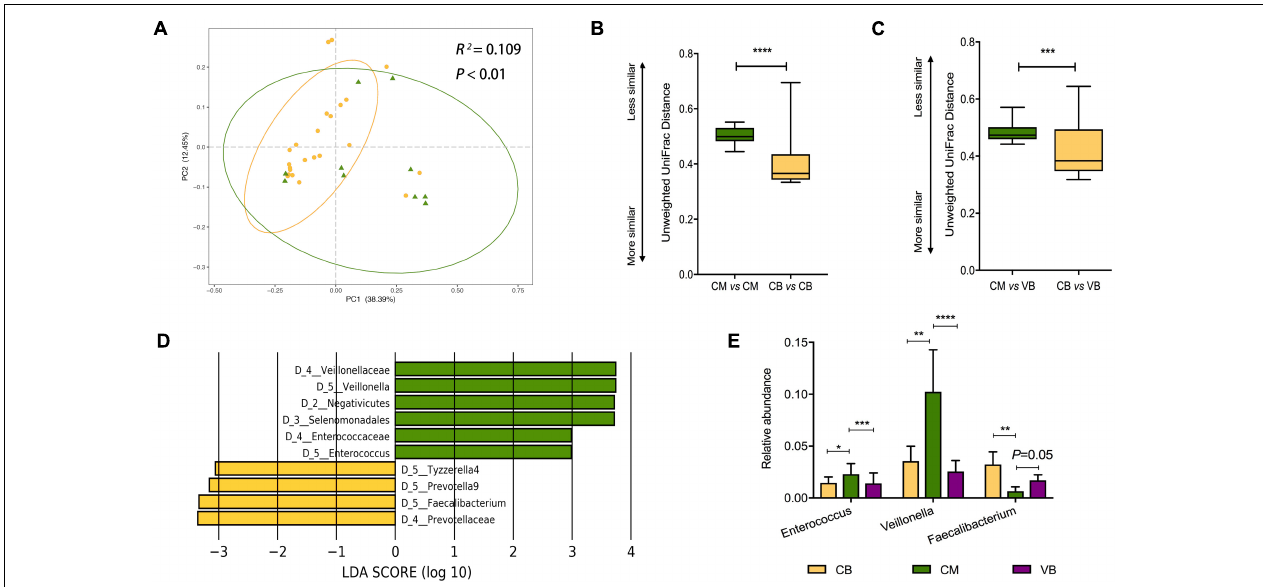
FIGURE 3 | Exclusive breastfeeding significantly restores the gut microbiota of cesarean delivered infants. (A) Principal coordinates analysis (PCoA) based on unweighted UniFrac distances is shown along the first two principal coordinate (PC) axes with Adonis p -value. Percentages are the percent variation explained by each PC axis. Individual samples are represented by yellow points (CB) and green triangles (CM). Comparison of the within-groups (B) and between-groups (C) unweighted UniFrac distances of CB and CM infants. Shorter distance indicated greater similarity between microbial community composition. Significant difference was determined by Mann-Whitney U -test ( ∗ p < 0.05, ∗∗ p < 0.01, ∗∗∗ p < 0.001, ∗∗∗∗ p < 0.0001). (D) Enriched taxa of different level from CB infants with a positive linear discriminant analysis (LDA) score are shown in yellow; CM infants with negative LDA score are shown in green (cut off value ≥ 3). (E) Comparison of relative abundance of Enterococcus , Veillonella, and Faecalibacterium among VB, CB, and CM infants. VB, vaginally delivered and exclusive breastfed; CB, cesarean delivered and exclusive breastfed; CM, cesarean delivered and